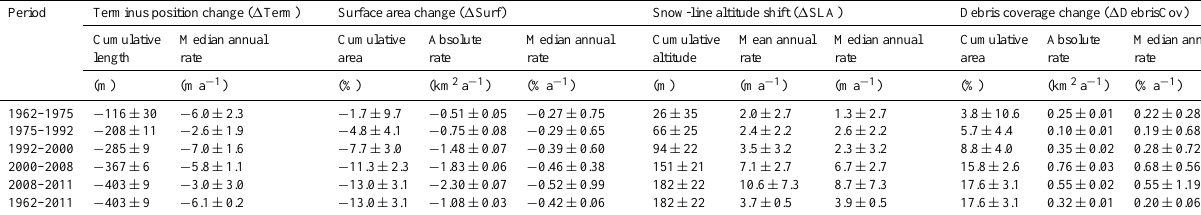
Table 2. Glacier changes from 1962 to 2011 in the Mt. Everest